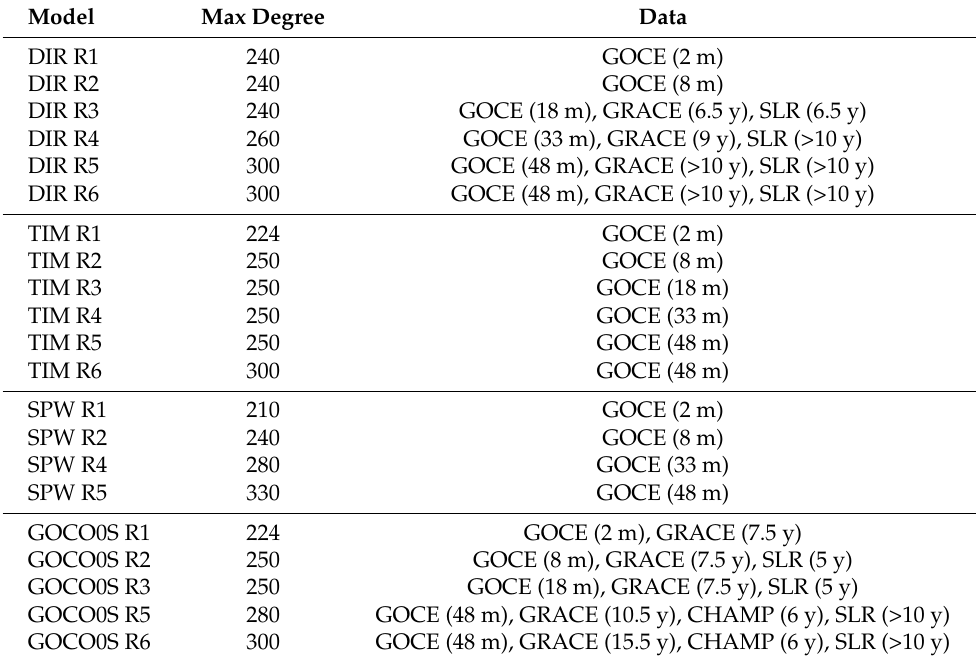
Table 1. Tested global geopotential models and their data